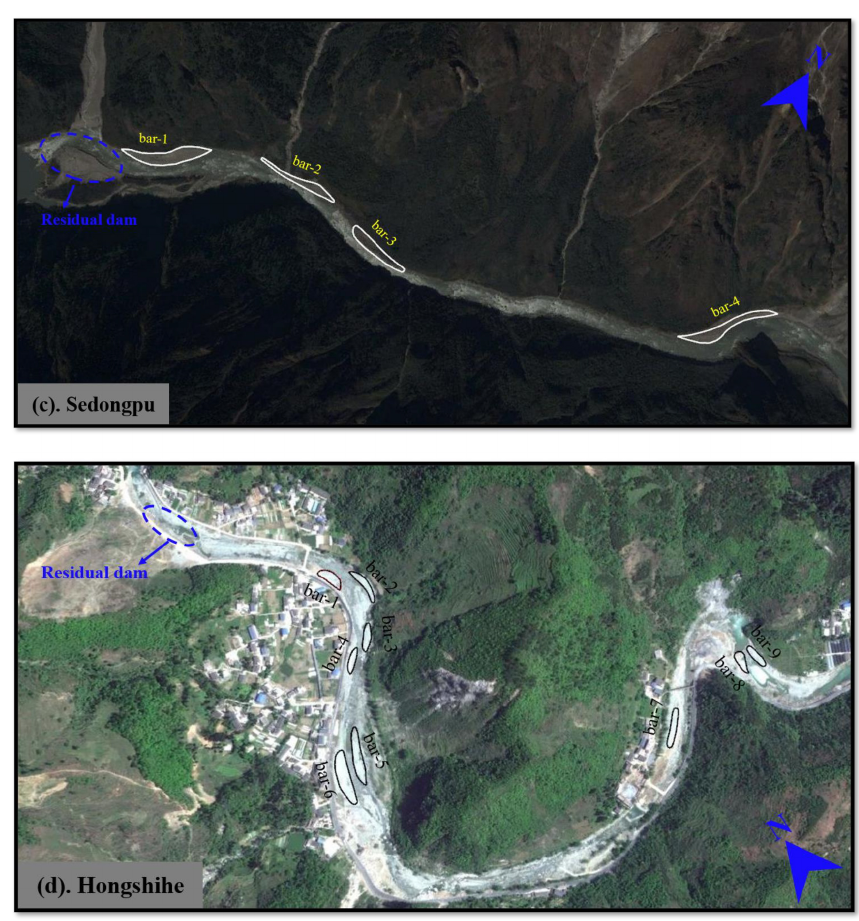
Figure 9. Thirty-eight boulder bars of four cases caused by outburst flood events from Google Earth satellite images, © Google Earth.